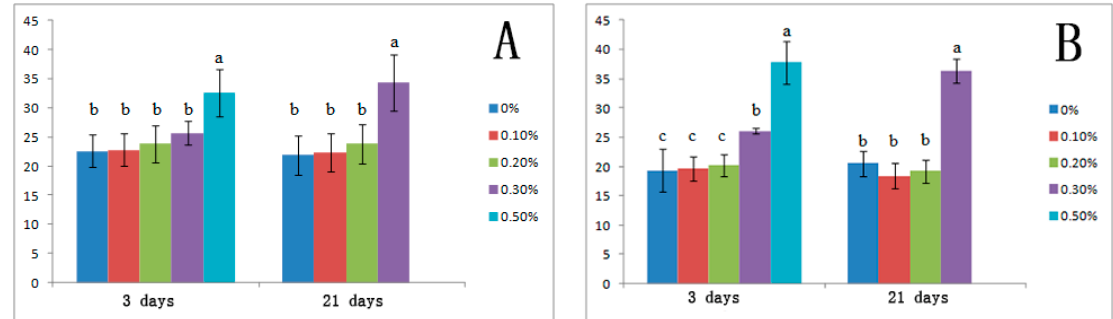
Figure 1. ( A ) Cell membrane stability (%) in leaves ( A ) and roots ( B ) of mulberry plants grown for 3 and 21 days with increasing levels of soil salinity under greenhouse conditions. Data with the same letter are not significantly different ( P = 0.05).